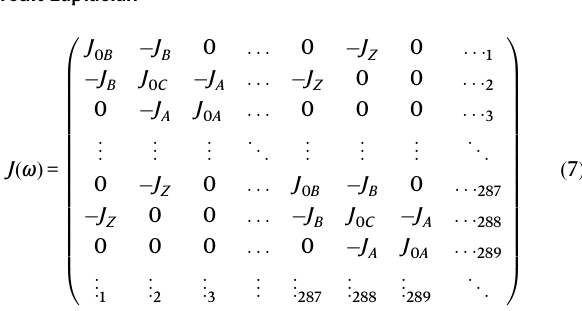
current fl owinginto node a , V b thevoltage ofnode b , and J ab ( ω ) being